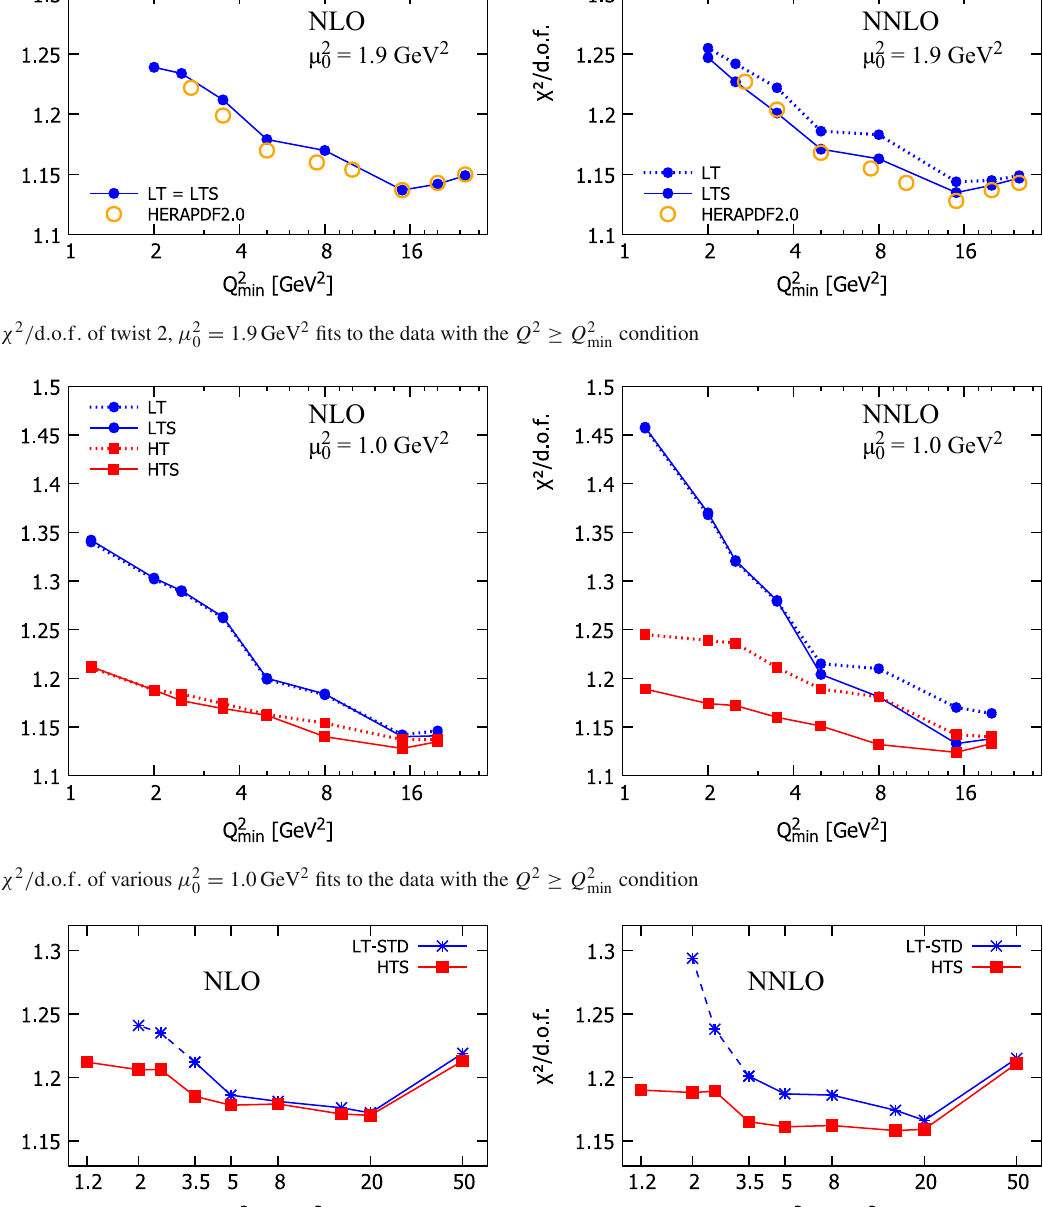
Fig. 3 The χ 2 / d . o . f . for the LT-STD and HTS fits vs. lower Q 2 cut, Q 2